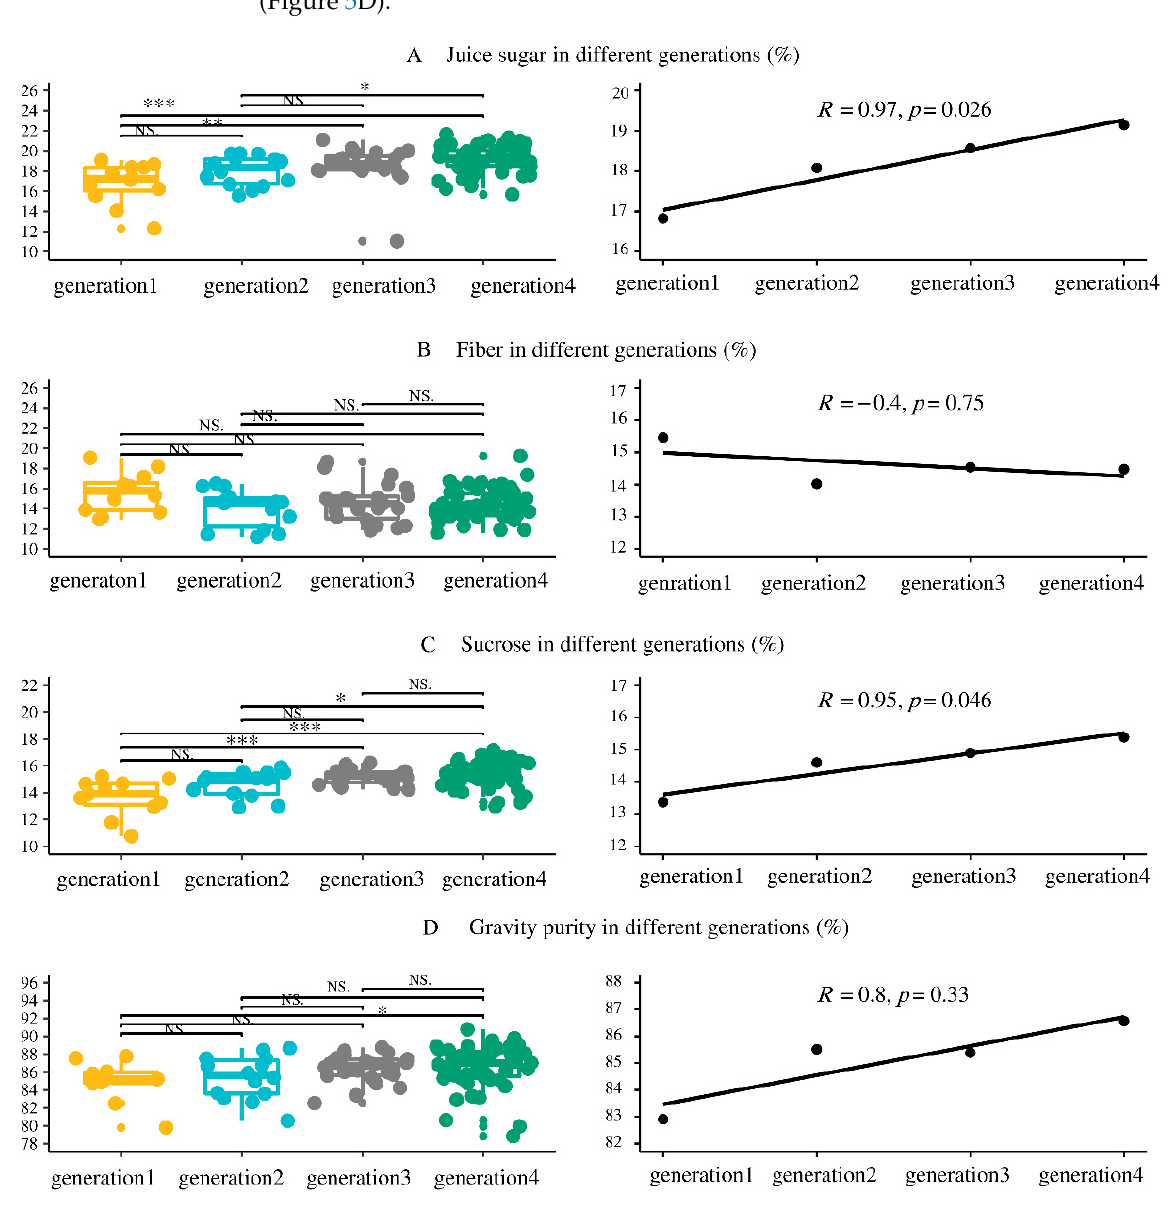
Figure 5. Differences among the four generations. NS, p > 0.05; * p < 0.05; ** p < 0.01; *** p < 0.001,